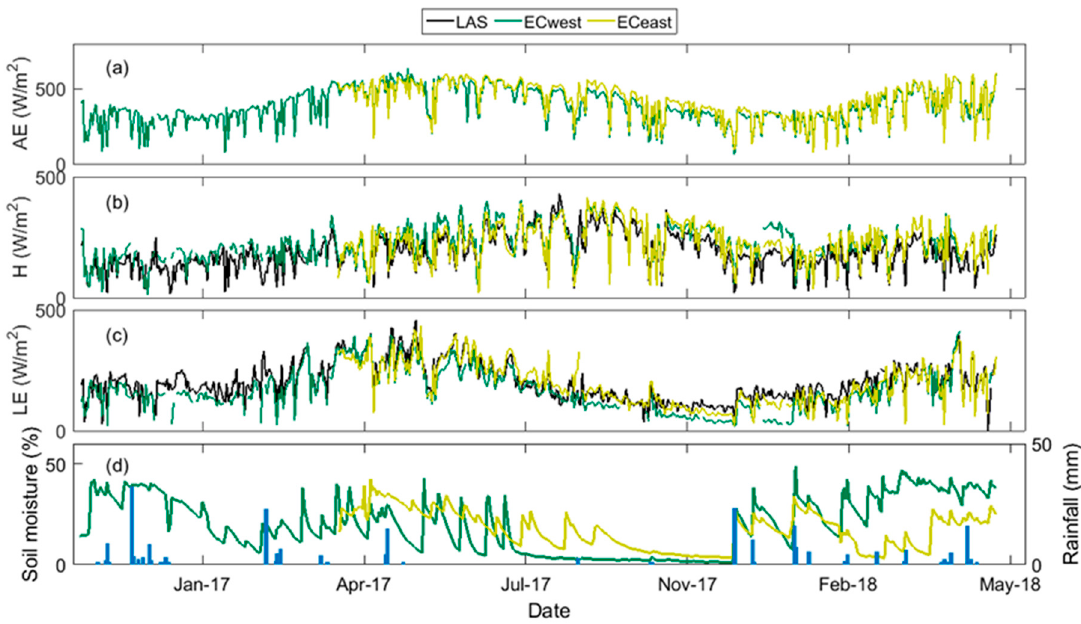
Figure 4. Daily variation of ( a ) Available energy (AE); ( b ) Sensible heat (H); ( c ) Latent heat (LE) and ( d ) Soil moisture from October 2016 to May 2018. ECwest, ECeast and LAS measurements were superimposed for comparison purposes.